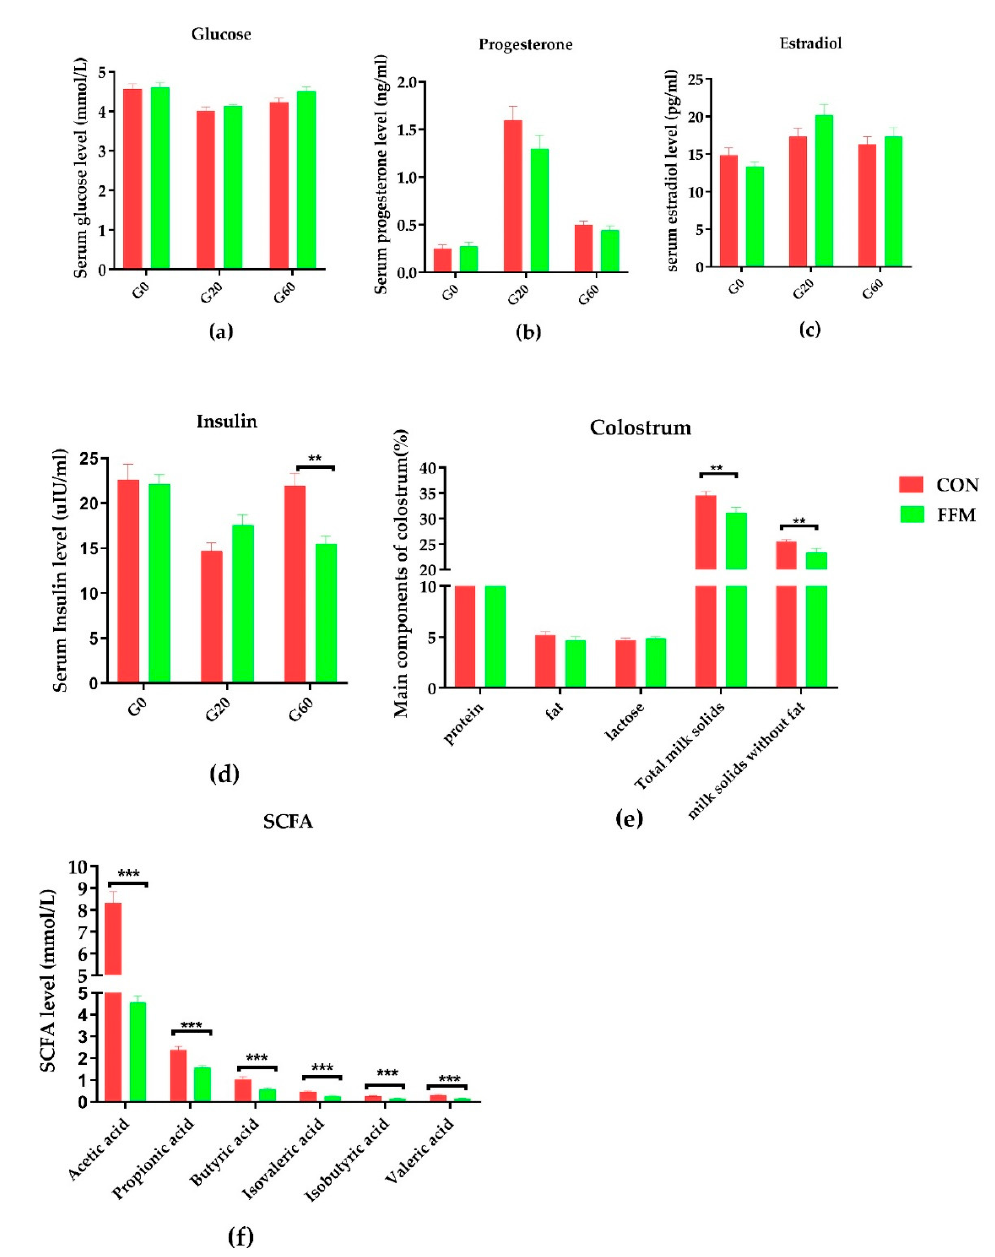
Figure 3. Effects of FFM supplementation on glucose, hormones, and fecal SCFAs. The concentrations of glucose ( a ), progesterone ( b ), insulin ( c ), and estradiol ( d ) in the serum in CON ( n = 16) and FFM ( n = 15) sows. G0, G20, and G60 represent gestation days 0, 20, and 60. Components in the colostrum ( e ) for CON ( n = 14) and FFM ( n = 16). The short-chain fatty acid (SCFA) concentrations in the feces ( n = 8) ( f ). CON represents the control diet. FFM represent the diet with 25.5% fermented feed mulberry. TMS means the total milk solid concentration; * represents p < 0.05, and ** represents p < 0.01, *** represents p < 0.001.